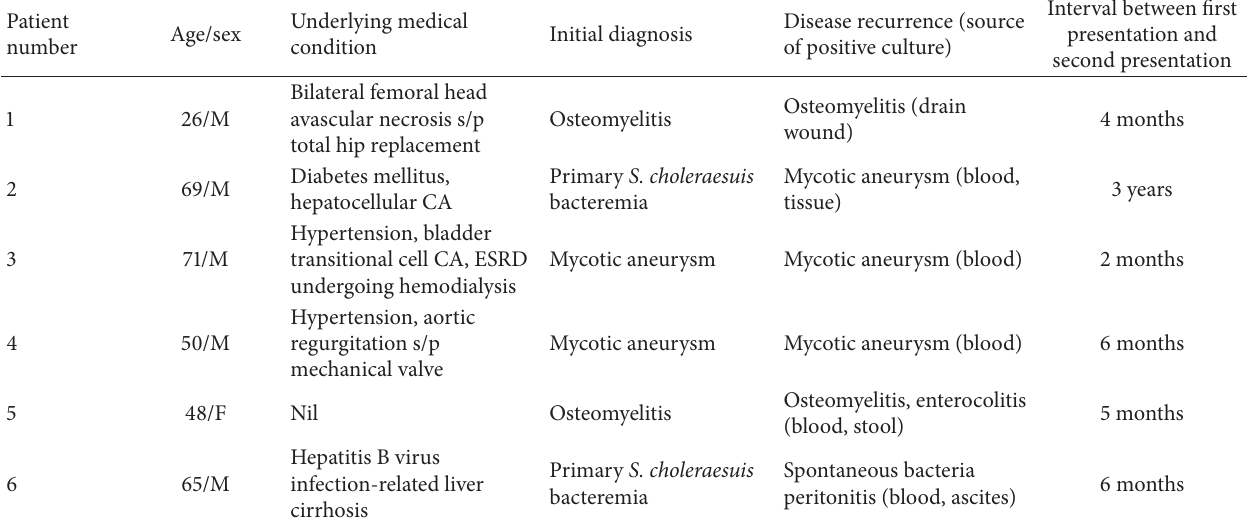
Table 1: Summary of clinical features of patients with recurrent S. choleraesuis infections. [7] Copyright © 2006 Cambridge University Press. Reprinted with the permission of Cambridge University